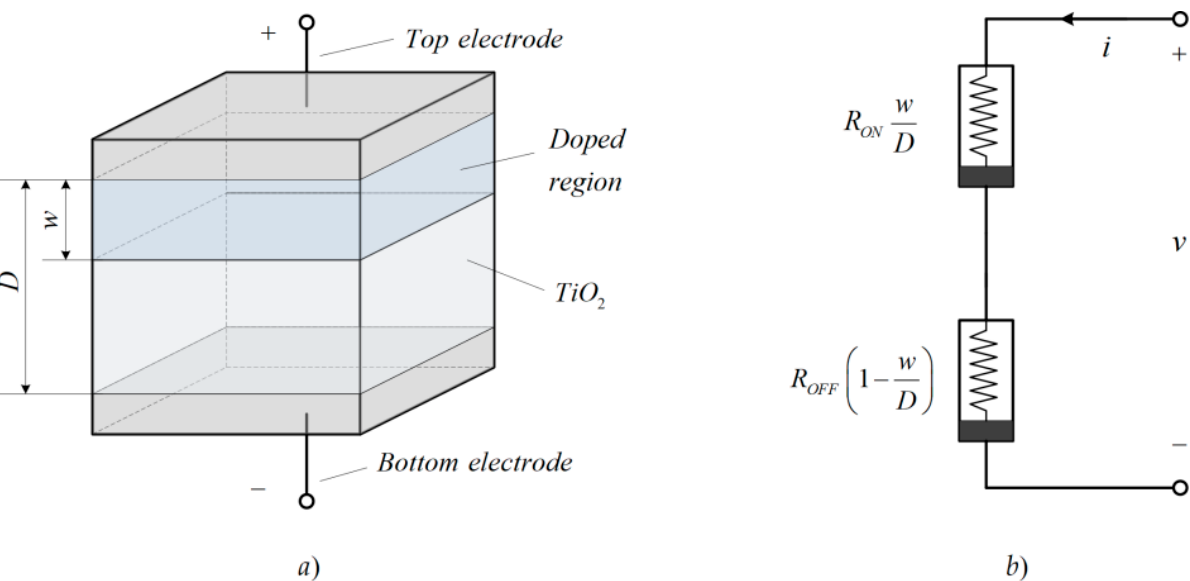
Figure 1. ( a ) Memristor nanostructure representing the metallic contacts (top electrode and bottom electrode), the doped and un-doped layers of the memristor; ( b ) An equivalent electric circuit representing the resistances of the doped and the un-doped regions connected in series.